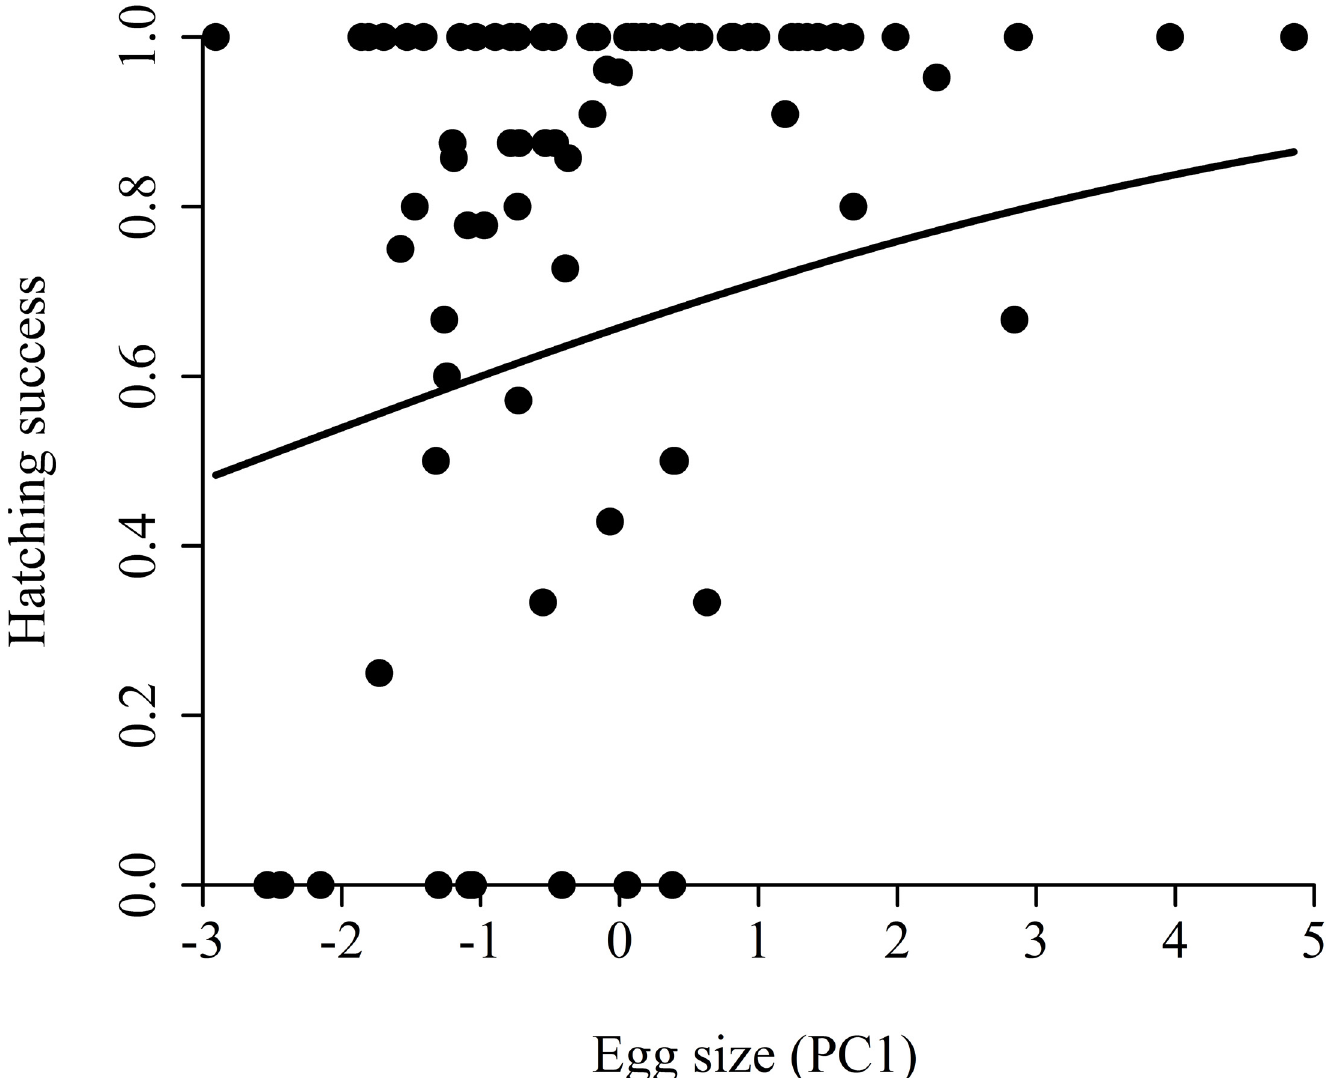
Fig 3. Relationship between hatching success and egg size. Hatching success was calculated as the proportion of hatched eggs in each environment. As environment had no effect on hatching success, the regression line is fitted to the pooled data.